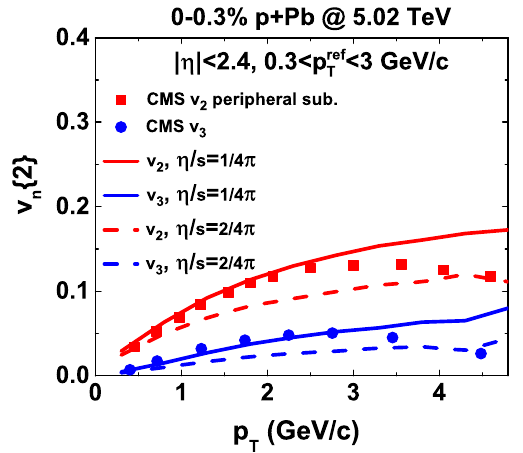
Fig. 5 The transverse momentum p T dependence of v 2 and v 3 of charged hadrons at | η | < 2 . 4 in 0–0.3% 5.02 TeV p + Pb collisions for different choices of viscosity to specific entropy ratio η/ s , compared to data from the CMS Collaboration